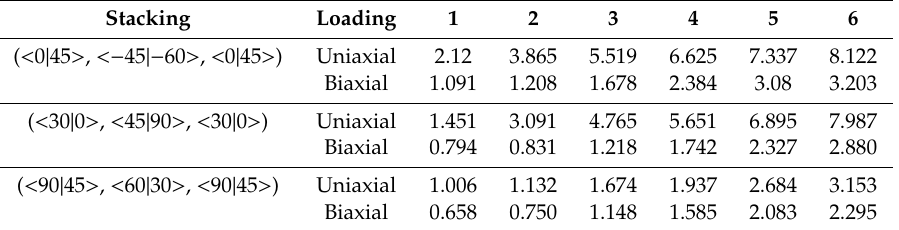
Table 8. Buckling load multipliers for the three-layer configurations of VS plates. Stacking Loading